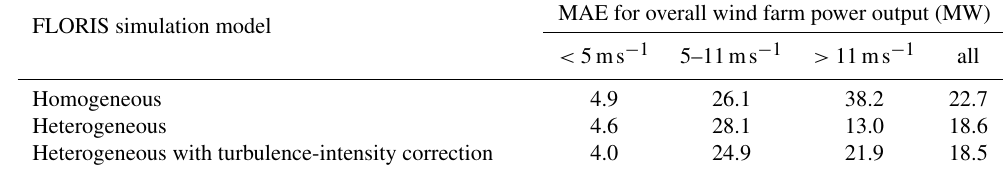
Table B3. Analysis of wake influence in the observed wind farm discussed in Sect. 4.2. This table shows the average mean absolute error in total wind farm power output for three different FLORIS models, omitting FLORIS wake loss calculations. This average was taken over all time steps, and the total rated wind farm output was scaled to 100MW for reference.